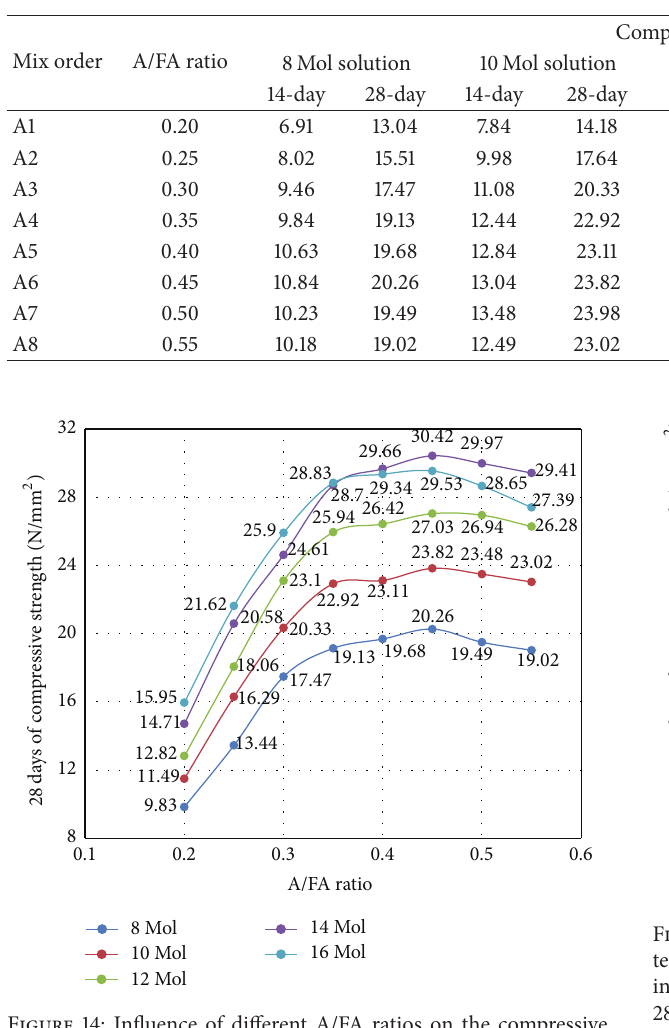
Figure 14: Influence of different A/FA ratios on the compressive strength of OPSGPC at different molarities.